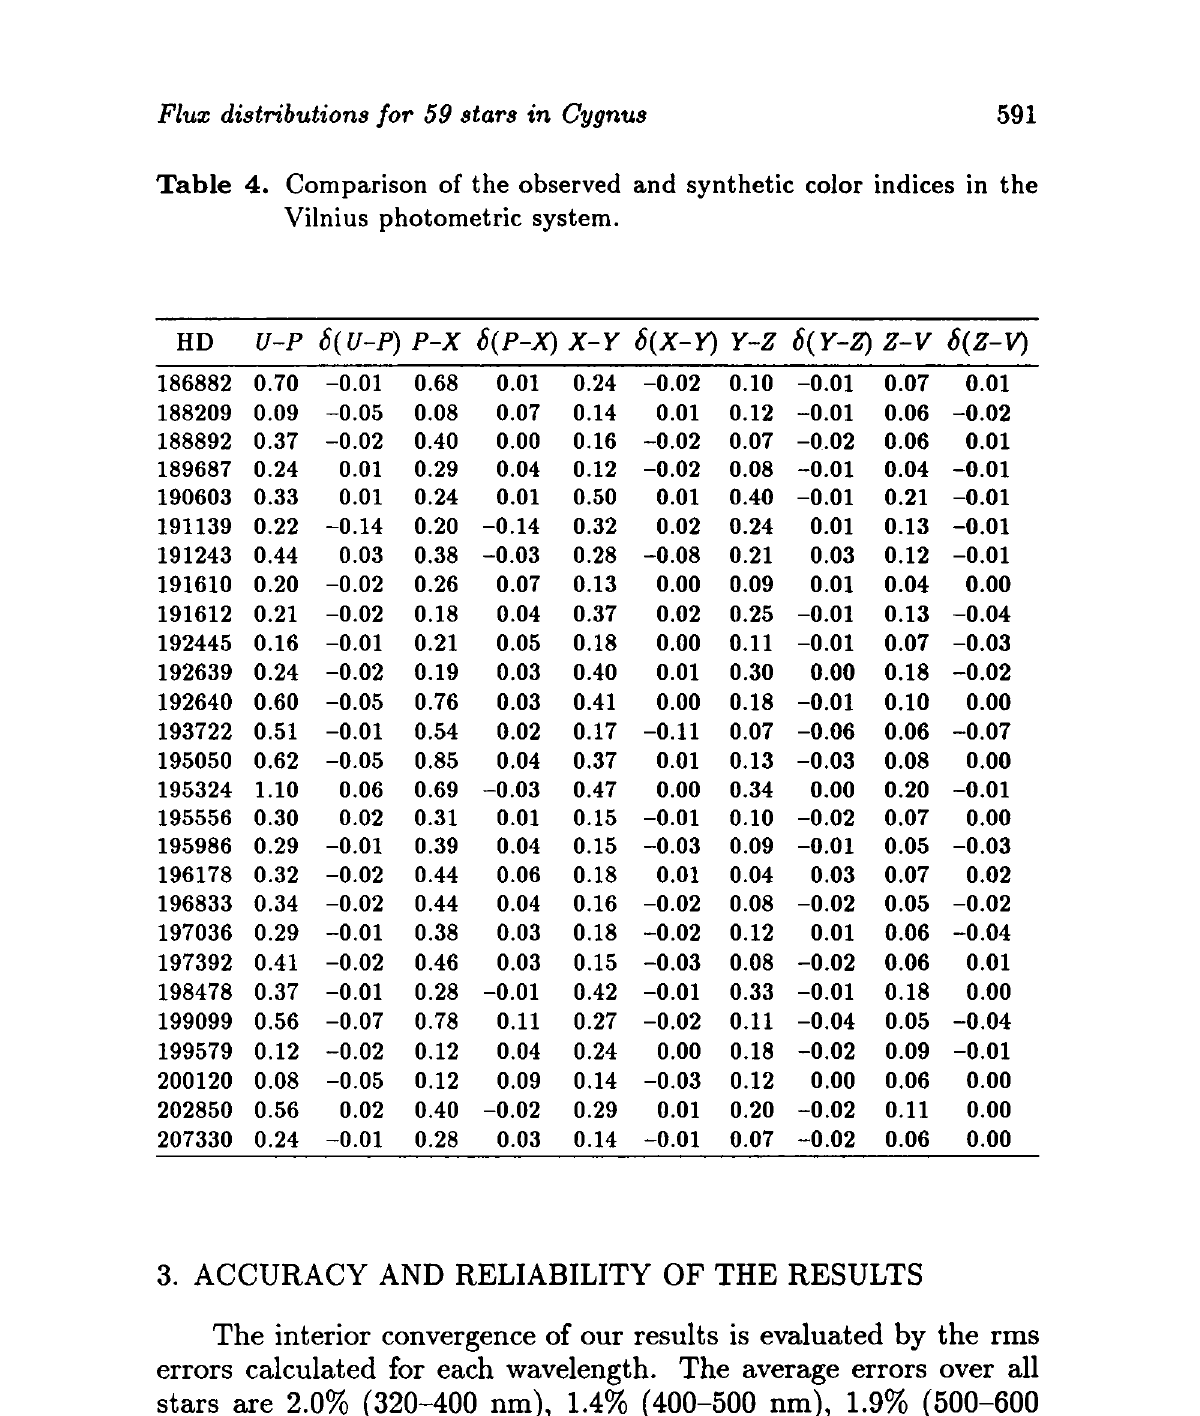
Table 4. Comparison of the observed and synthetic color indices in the Vilnius photometric